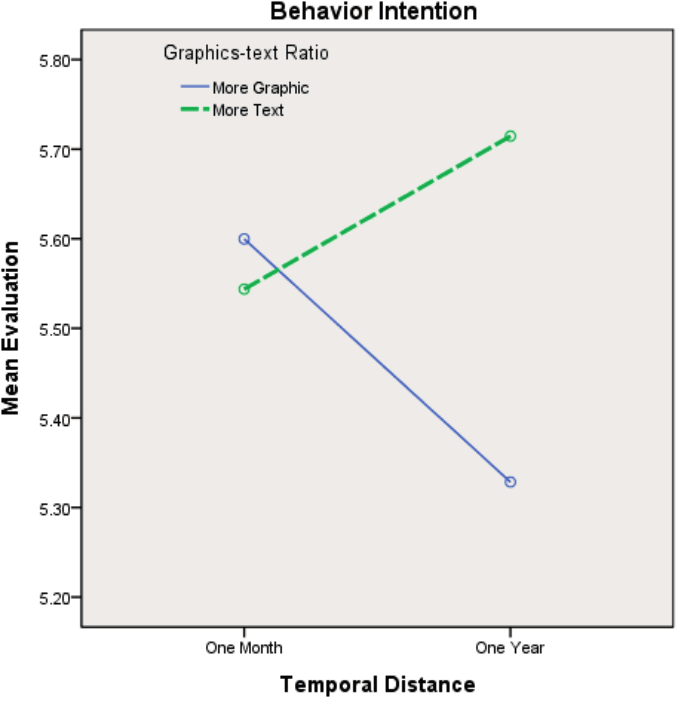
Figure 5. Interaction effects between temporal distance and the graphics-text ratio on behavior